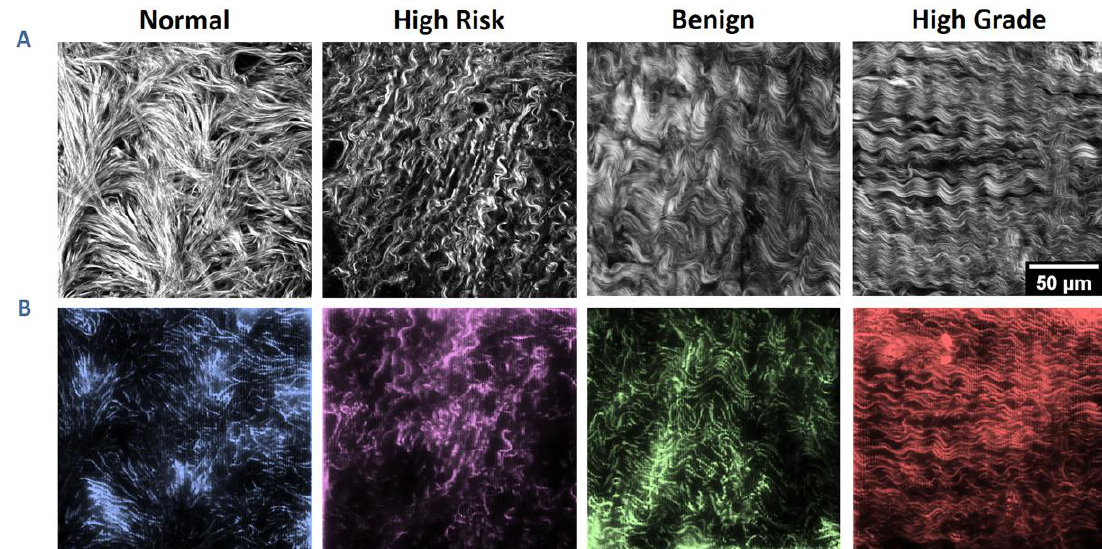
Figure 1. Ovarian stromal images and corresponding fabricated scaffolds. ( A ) Second-Harmonic Generation (SHG) optical sections of collagen from the four categories of ovarian tissues. ( B ) Two-photon excited fluorescence images of the resulting respective scaffolds. Each pattern is 200 × 200 µm in size with 10 µm in height. Scale bar = 50 µm.